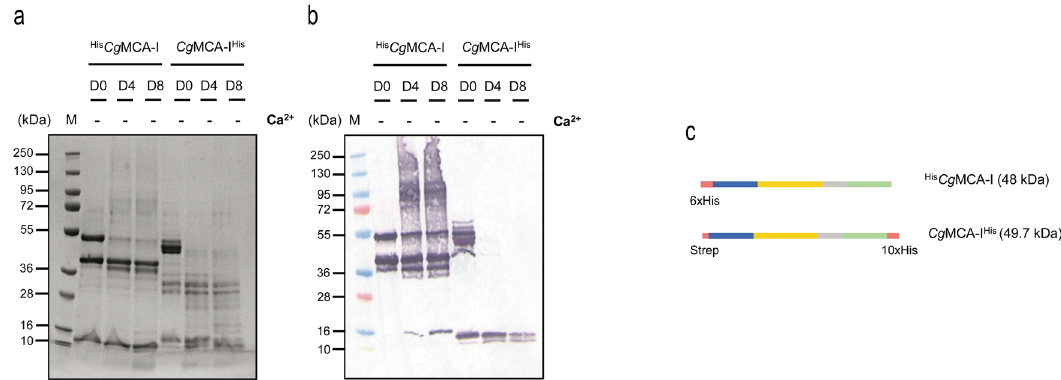
Fig. 2 Maturation of His Cg MCA-I and Cg MCA-I His . SDS-PAGE ( a ) and Western-blot ( b ) analysis of aliquots of His Cg MCA-I and Cg MCA-I His constructs at D0, D4, and D8 in the absence of Ca 2 + . ( c ) Schematic representation of His Cg MCA-I and Cg MCA-I His